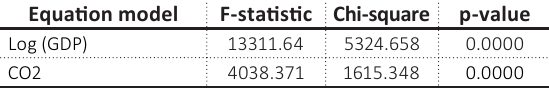
Table 7. Simultaneous significance test